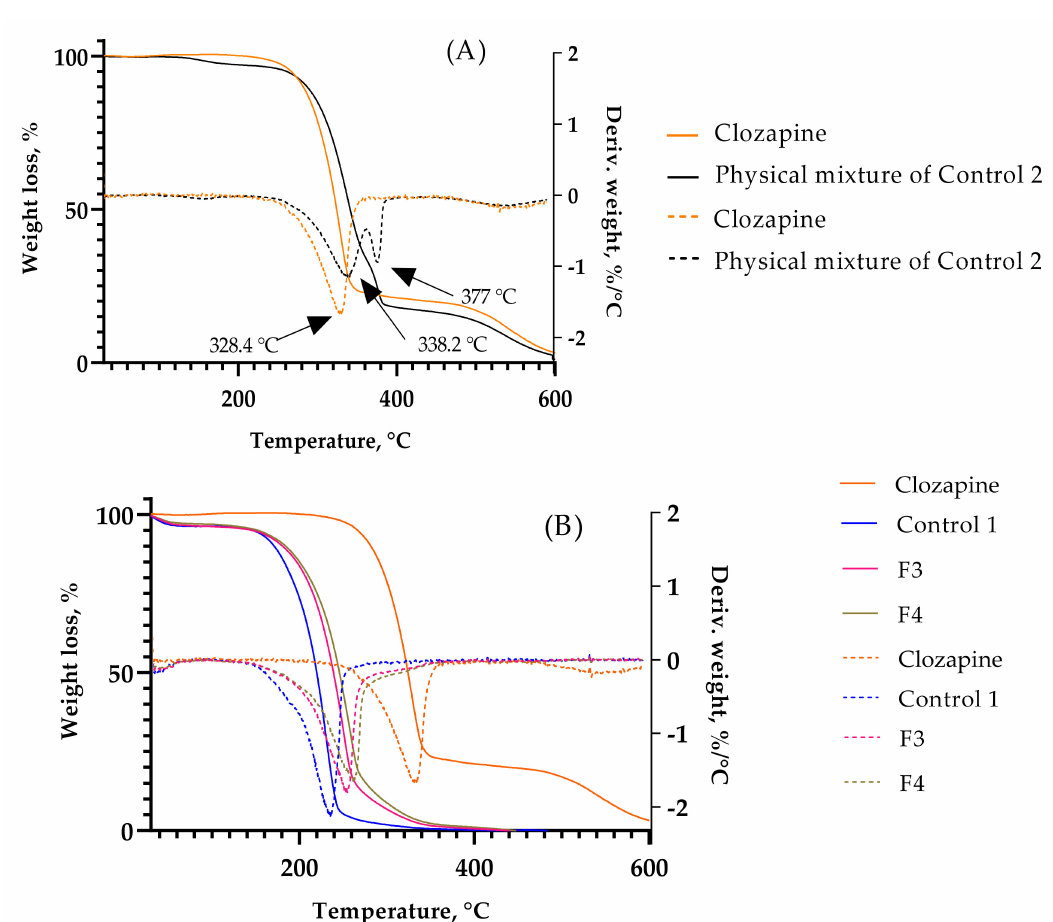
Figure 12. TGA (solid line) and DTG (dashed line) of ( A ) clozapine and physical mixture of Control 2, and ( B ) clozapine, Control 1, F3 and